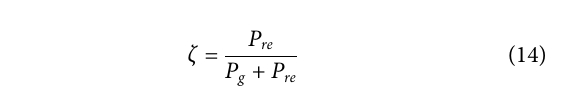
Figure 9 . Load growth decreases the reliability of power systems. The